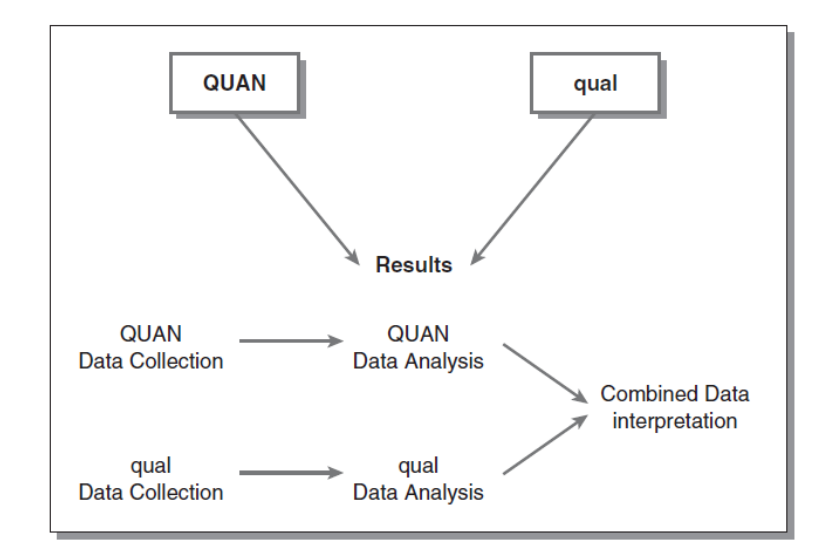
Figure 1 . Concurrent triangulation design by Creswell, Plano Clark, Gutmann, & Hanson